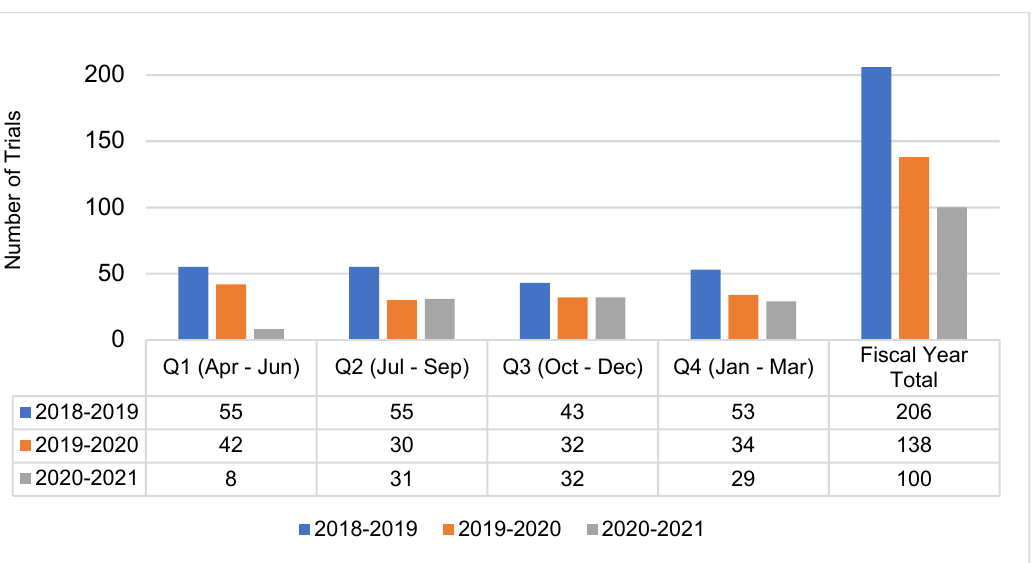
Figure 1. Recruitment to 3CTN Portfolio trials at adult cancer centers ( n = 41) from April 2018–March 2021.